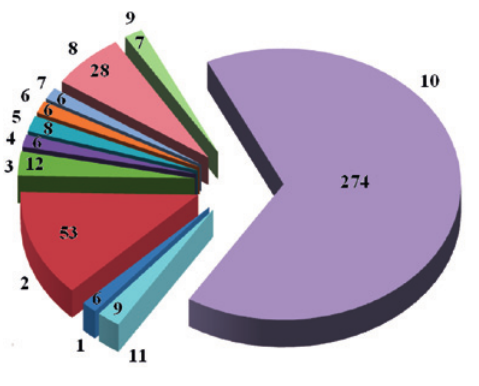
Fig. 2. The number of trainees who participated in the flight safety training courses at the ICAO Training Institute in 2011: